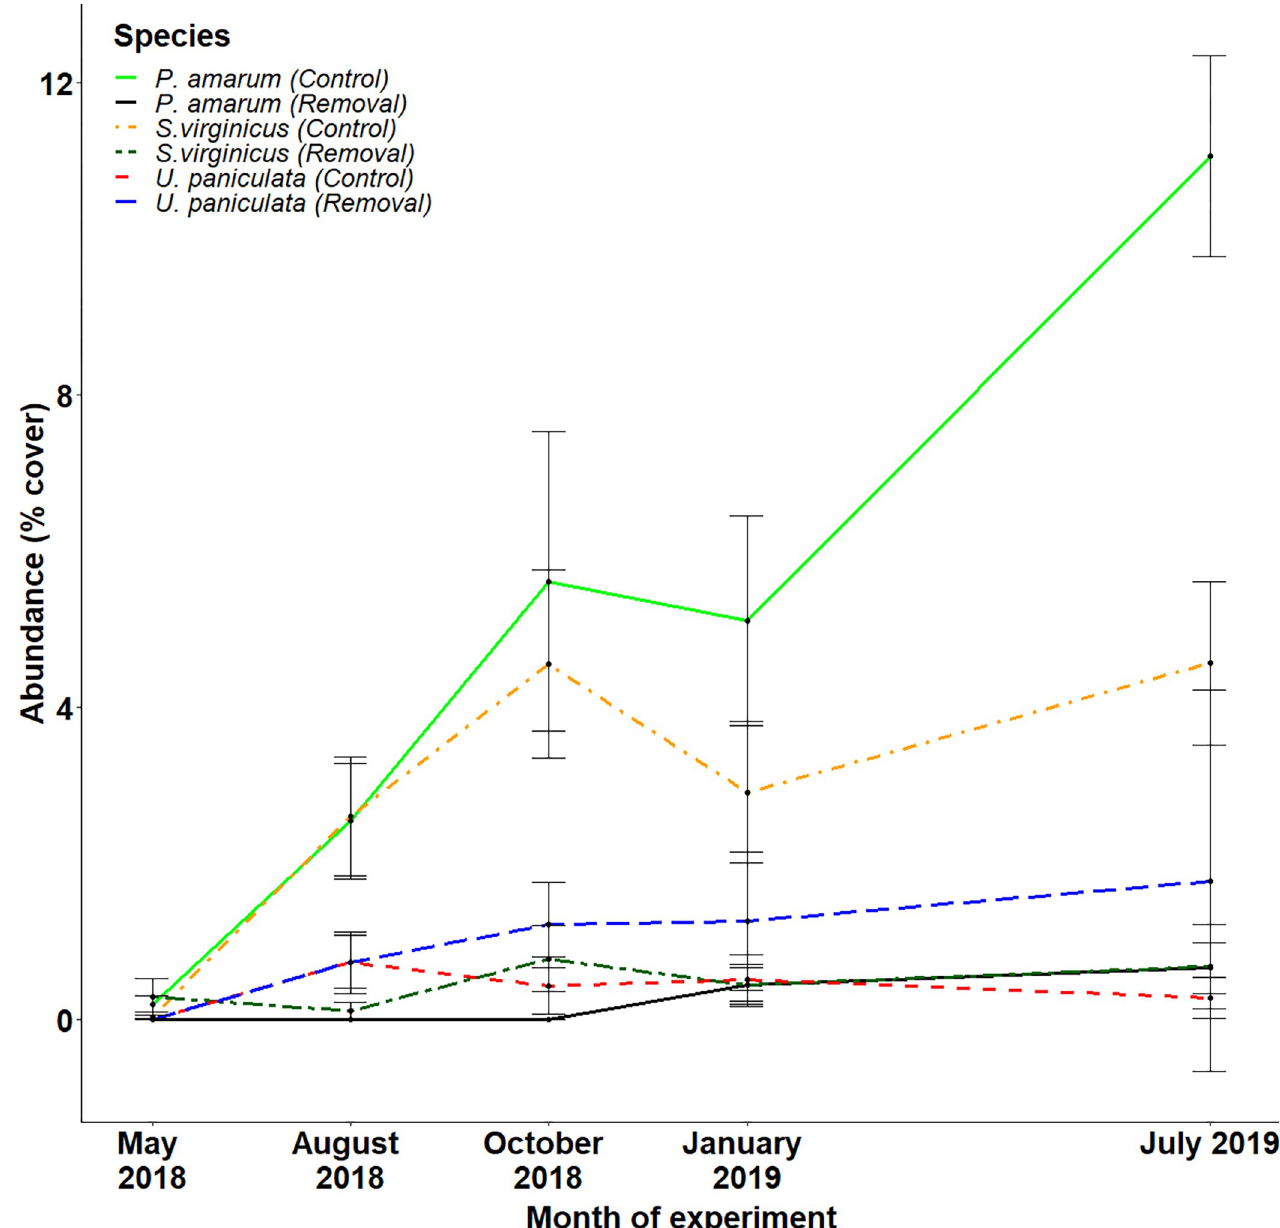
Fig 2. Changes in the abundance of grass species in control plots during the first 16 months of the experiment. Mean ( ± se) cover of P . amarum , S . virginicus and U . paniculata in control plots (March 2018 –July